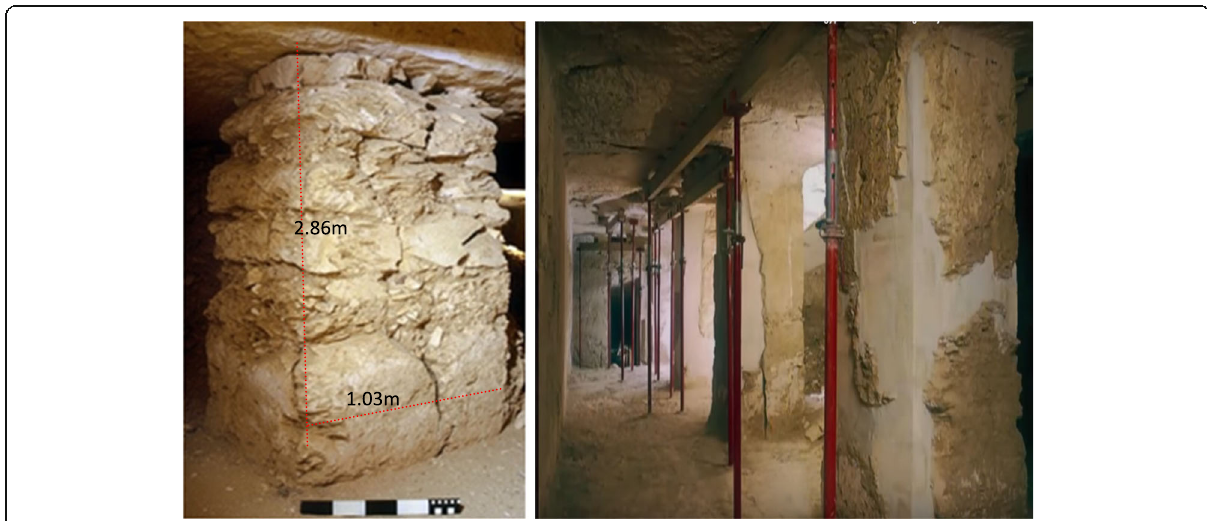
Fig. 35 Present state of the sixteen supporting rock pillars in the Chamber 3. which are structurally damaged. Vertical cracks due to the overloading and strength regression are obvious (http://www.thebanmappingproject.com/). Permission was granted by Weeks, K.R. © Theban Mapping Project 2006 to reuse this